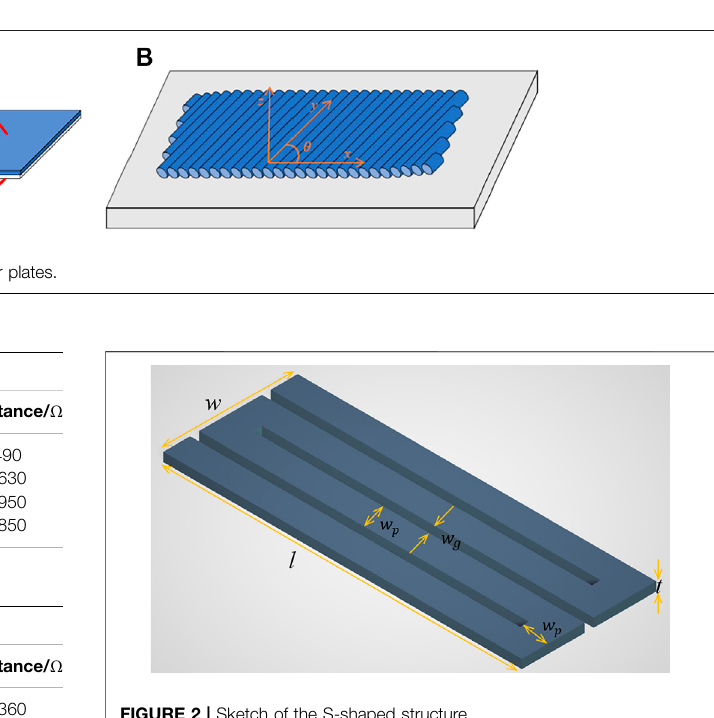
FIGURE 2 | Sketch of the S-shaped